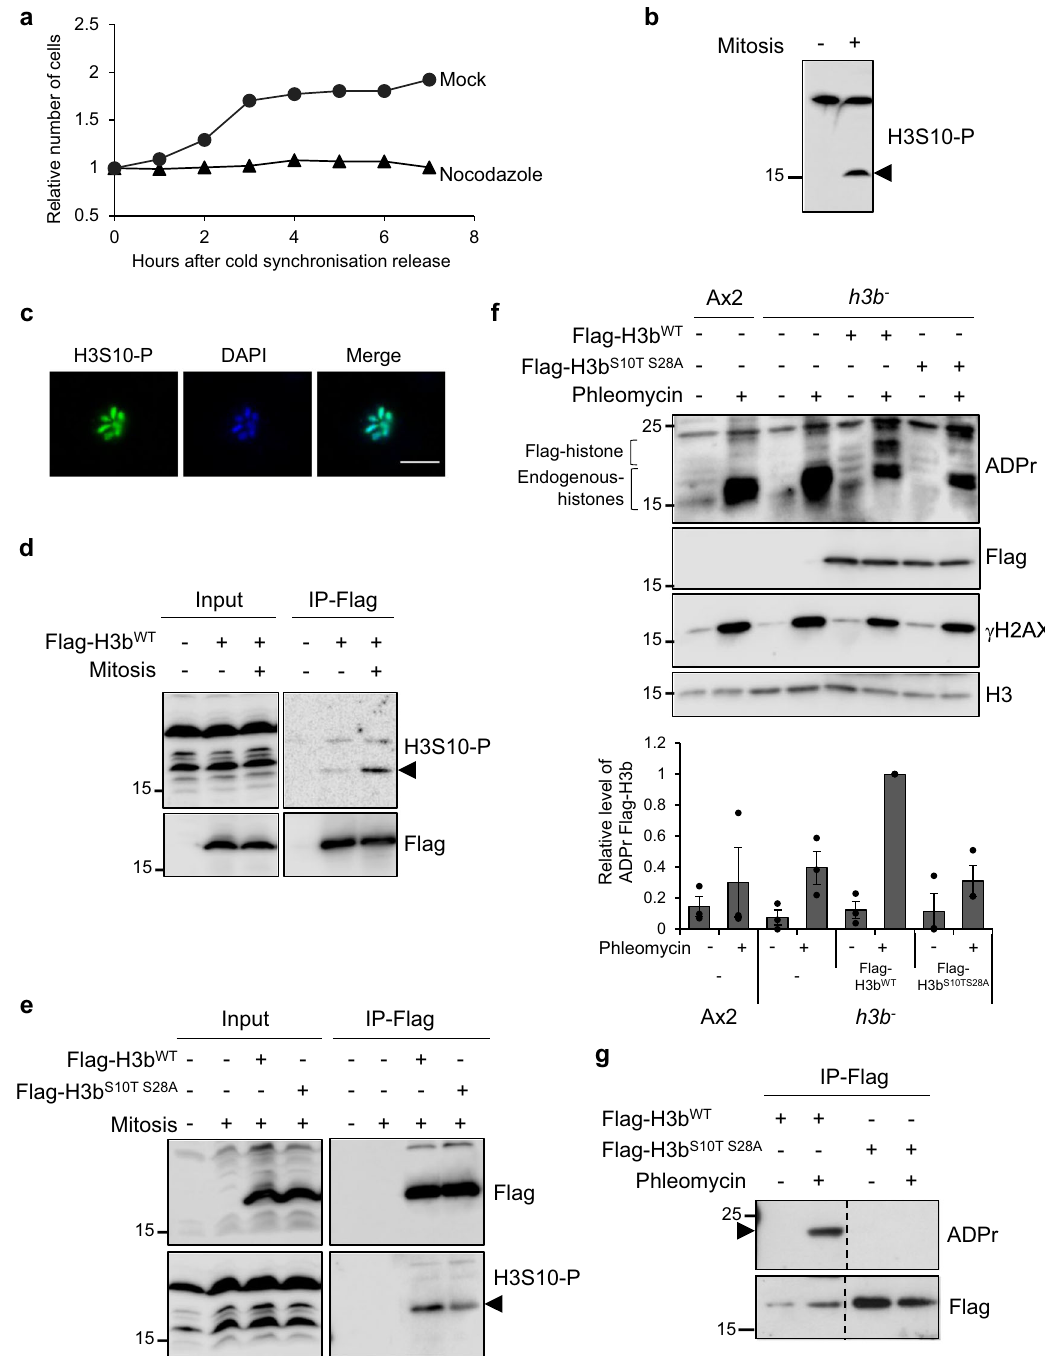
Fig. 3 Separation of function of H3b serine phosphorylation and ADP-ribosylation. a Ax2 cells were blocked in G2 and then released from cell cycle arrest in the absence or presence of nocodazole as indicated. Progression through mitosis was monitored by assessing cell numbers at times following release from G2. Quanti fi cation of one representative experiment from 3 biological repeats. b , c Asynchronous or nocodazole arrested Ax2 cells were subjected to Western blotting of whole cell extracts ( b ) or immuno fl uorescence ( c ) using an H3S10-P speci fi c antibody. Molecular weight markers are indicated in kDa. Scale bar 5 μ m. d , e Cells containing empty vector or expressing Flag-H3b WT ( d ) and Flag-H3b WT or Flag-H3b S10TS28A ( e ) were left untreated or synchronised in mitosis with a nocodazole block as indicated. Input or Flag-immunoprecipitates were subjected to Western blotting using the indicated antibodies. Molecular weight markers are indicated in kDa. f The indicated cell lines were left untreated or exposed to phleomycin. Western blotting of acid extracts was performed using the indicated antibodies. ADP-ribosylated endogenous histones and Flag-H3b are highlighted. Enrichment of Flag-H3b in chromatin fractions was quanti fi ed (lower panel; n = 3; individual data points are shown and error bars represent the SEM). Molecular weight markers are indicated in kDa. g h3b − cells expressing Flag-H3b WT or Flag-H3b S10TS28A were left untreated or exposed to phleomycin as indicated. Western blotting of Flag-immunoprecipitates was performed using the indicated antibodies. Molecular weight markers are indicated in kDa. All experiments represent at least three biological repeats. Source data are provided in the Source Data fi